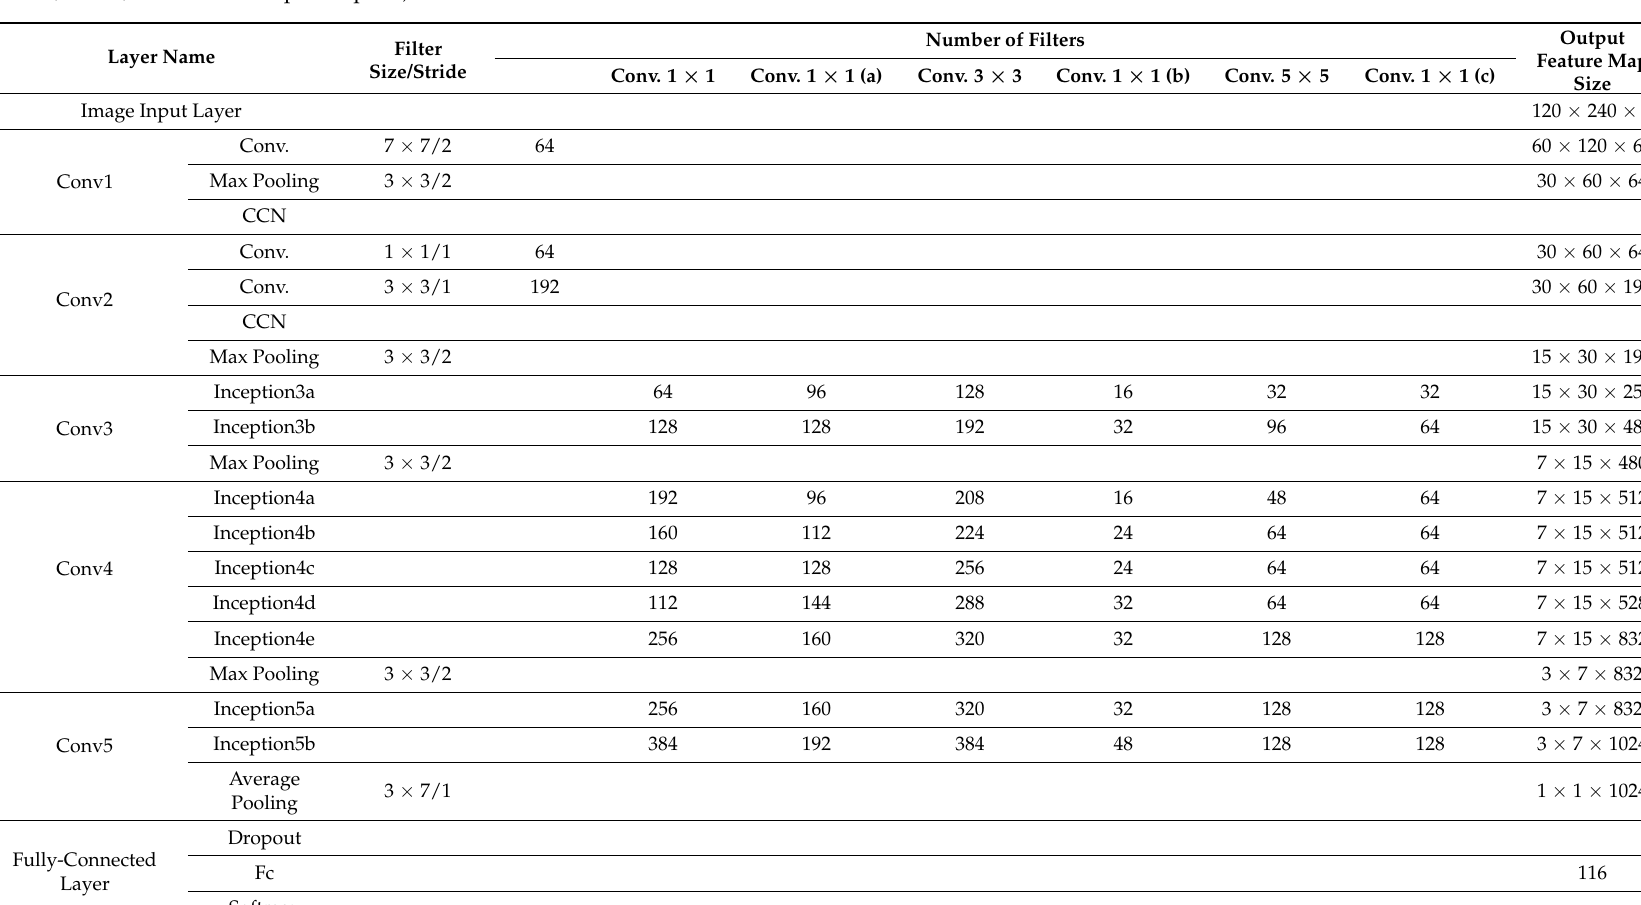
Table 4. Architecture of GoogleNet used in this study. “Conv. 1 × 1 (a)” and “Conv. 1 × 1 (b)” denote the 1 × 1 convolutional layers used for 3 × 3 and 5 × 5 convolutional computing reduction, respectively, “Conv. 1 × 1 (c)” denotes the 1 × 1 convolutional layers used for 3 × 3 pooling dimensional matching (unit of filter size, stride, and feature map size: